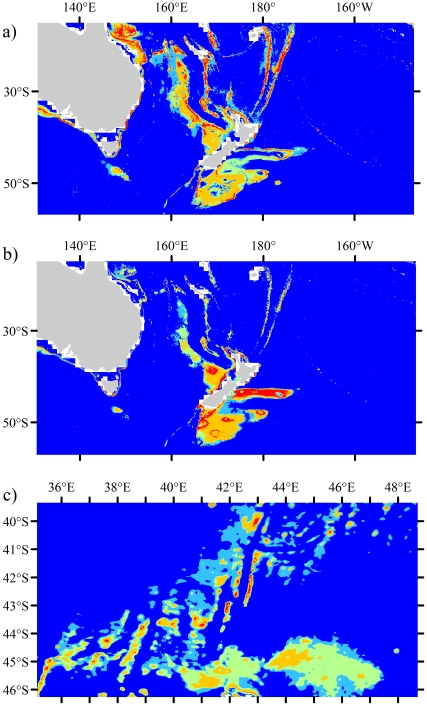
Local and regional area outputs for areas suitable habitat.a) E. rostrata around New Zealand and Australia, b) G. dumosa around New Zealand and Australia, c) S. variabilis on seamounts in the Southern Ocean south of Madagascar.